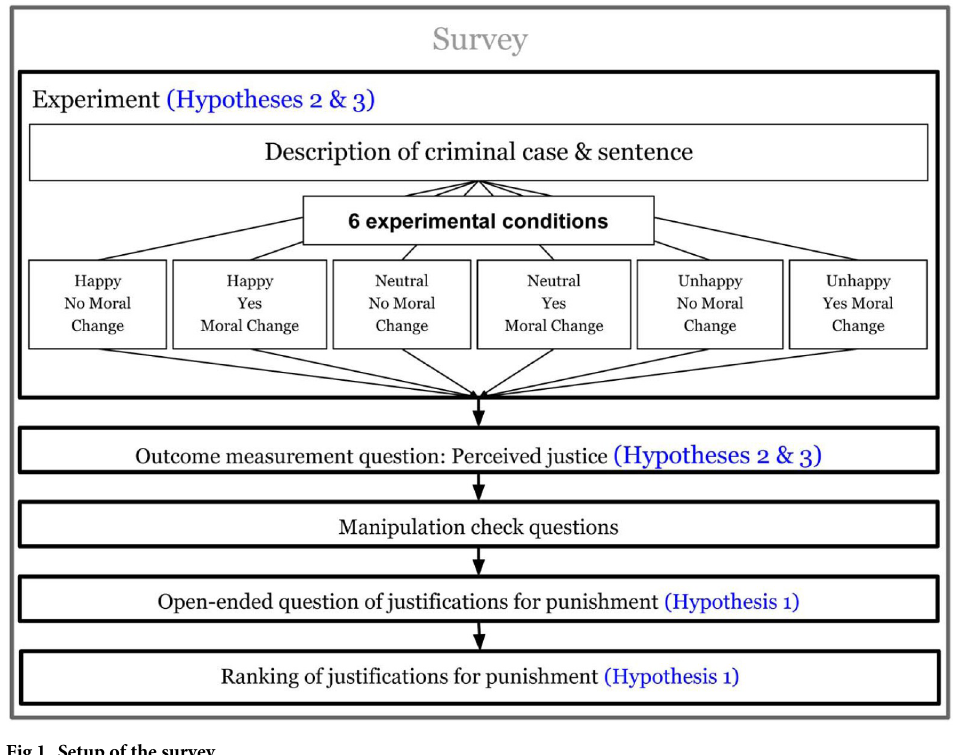
Fig 1. Setup of the